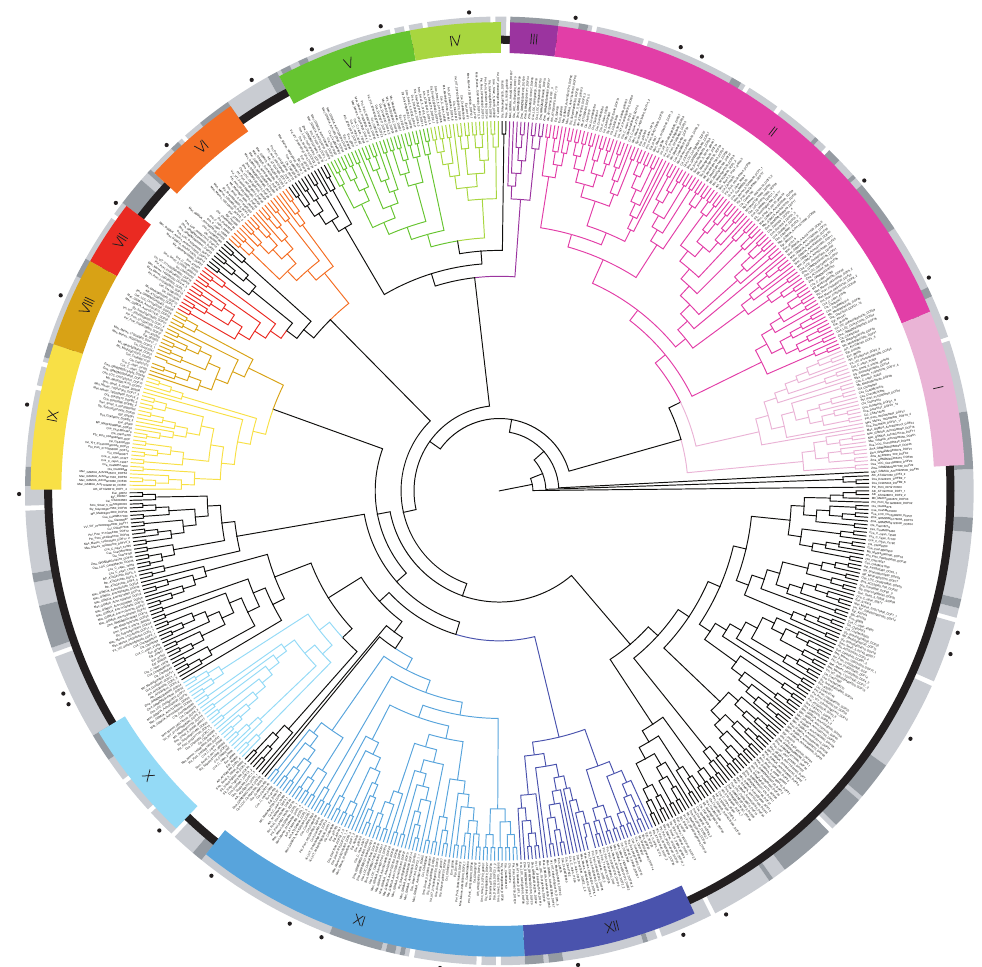
Figure 2. Phylogenetic tree of 615 DOF amino-acid sequences. Conserved clades with species representativity are colored, together with their branches. Outer circle colors denote sequences derived from monocots (dark grey), eudicots (light grey), and Selaginella moellendorffii (white). Black dots indicate Eugenia uniflora